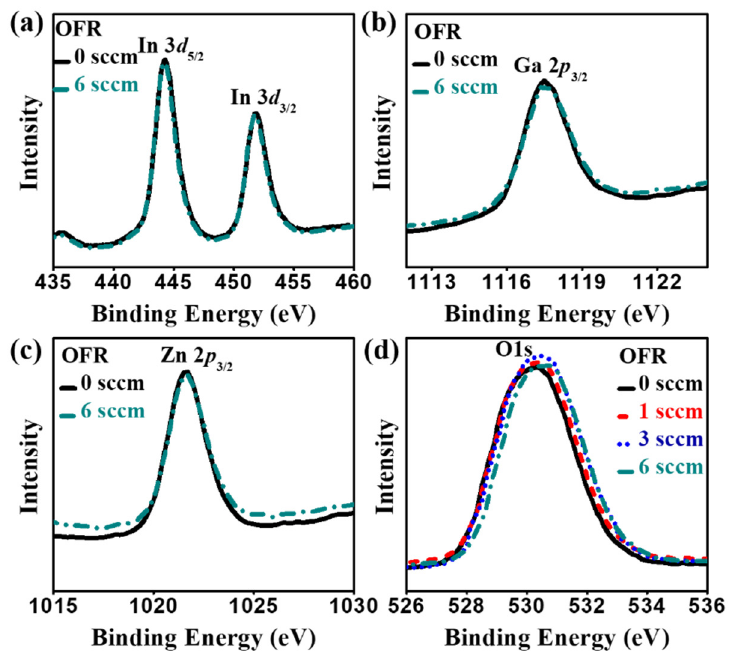
Figure 5. The XPS analysis of the as-deposited a -IGZO films with the different oxygen flow rates: ( a ) In 3d 5/2 ( b ) Ga 2p 3/2 ( c ) Zn 2p 3/2 and ( d ) O1s (solid, dash, dot and dash–dot lines are indicated for OFR at 0 sccm, 1 sccm, 3 sccm and 6 sccm, respectively).